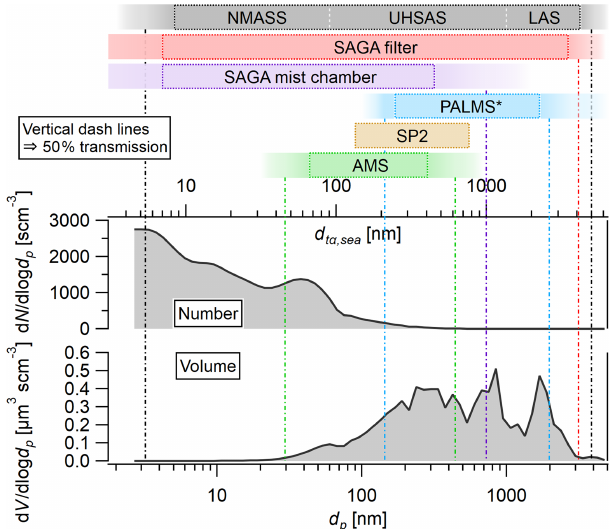
Figure 1. Approximate particle size ranges quantified by AMS, SP2, PALMS, SAGA MC, SAGA filters, and AMP (NMASS, UH- SAS, and LAS), plotted with the campaign-averaged AMP number and volume size distributions during ATom-2. For each instrument (except PALMS), the box indicates 100% inlet transmission and the transition shade on both sides indicates a decrease from 100% to 0%, with 50% denoted by the vertical dashed line. The PALMS bar represents the approximate observable size range at a 60min aver- aging timescale (at AMP size resolution) for composition data only (see Sect. S8). The top horizontal axis shows aerodynamic diame- ter ( d ta , sea ) and the bottom geometric diameter ( d p ); the conversion between the two diameters is based on ATom-2 campaign-averaged aerosol density of 1.70gcm − 3 and sea level P of 1013mbar using Eq.